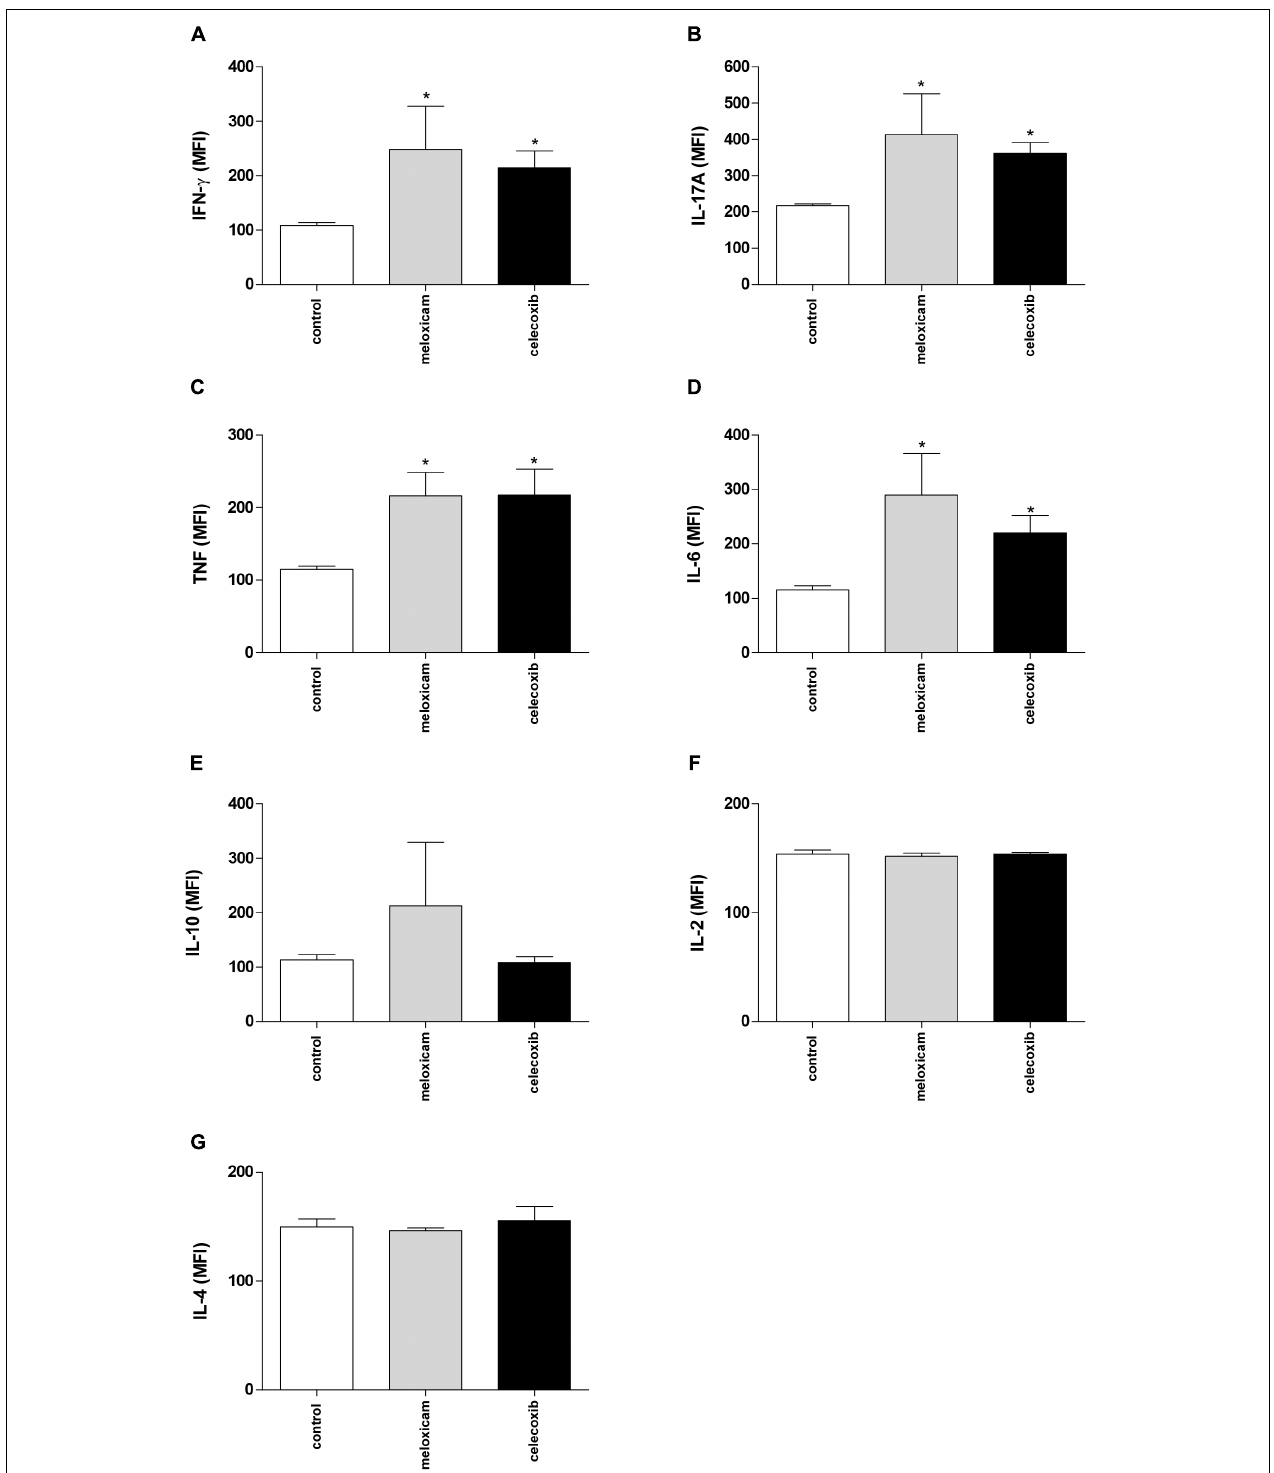
FIGURE 3 | Cytokine production in C. callosus after infection with T. gondii and treatment with COX-2 inhibitors. Females were infected orally with 50 cysts of T. gondii (ME49 strain), and treated or untreated with meloxicam (0.5 mg/kg) or celecoxib (5 mg/kg) daily for 40 days. The serum was collected for measurement of IFN- γ (A) , IL-17A (B) , TNF (C) , IL-6 (D) , IL-10 (E) , IL-2 (F) , and IL-4 (G) by CBA. Data are expressed as MFI according to the standard curve. Differences between groups were analyzed by one-way ANOVA with the Bonferroni multiple comparison post hoc test. Significant differences in relation to untreated/infected animals (control) ( ∗ P <